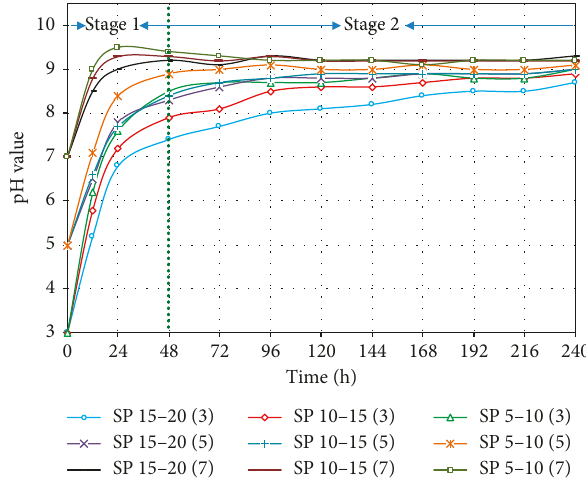
Figure 4: pH evolution trends under different immersion